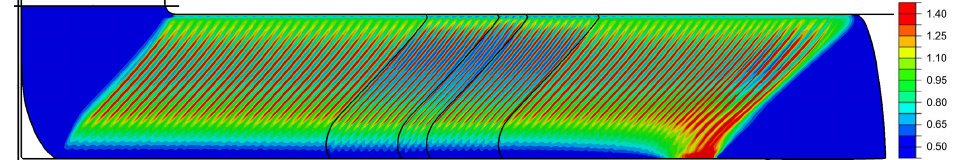
Figure 9. Contour plot of the effective plastic strain s (cf. Equation (9)) for the simulation with locally refined mesh. The billet is divided into five parts. The outer two parts are meshed with an element size of e = 0.5 mm, the two parts next to them with an element size of e = 0.25 mm and the part in the midst with an element size of e = 0.125 mm. Obviously, the solution is converged with respect to the dimensions of the shear and matrix